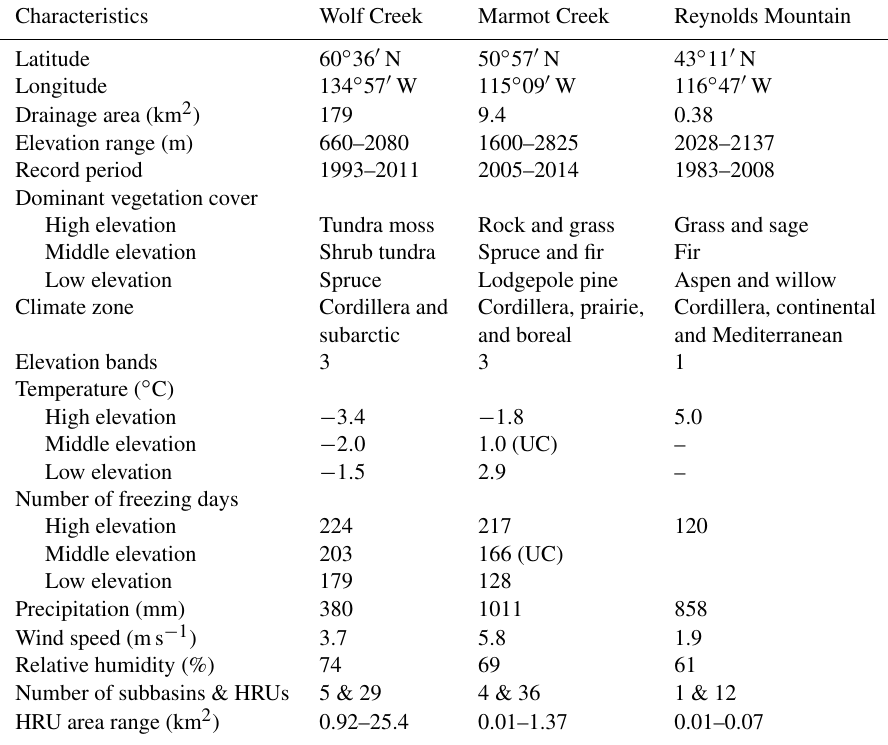
Table 1. Comparison of physiography and climatology amongst the three basins. UC denotes the “Upper Clearing” meteorological station in the Marmot Creek Research Basin.